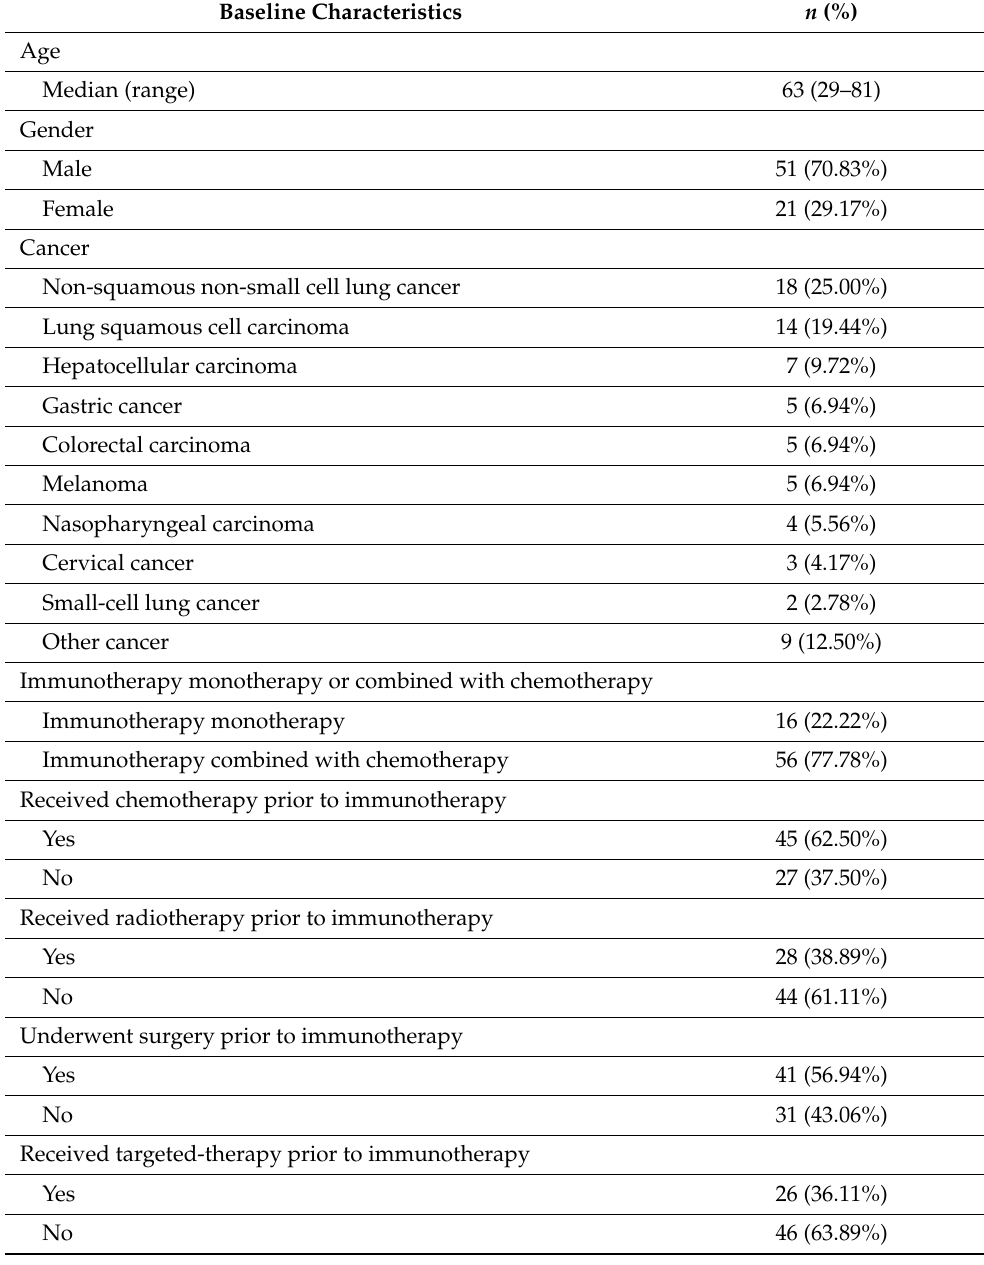
Table 1. The characteristics of patients at baseline ( n =